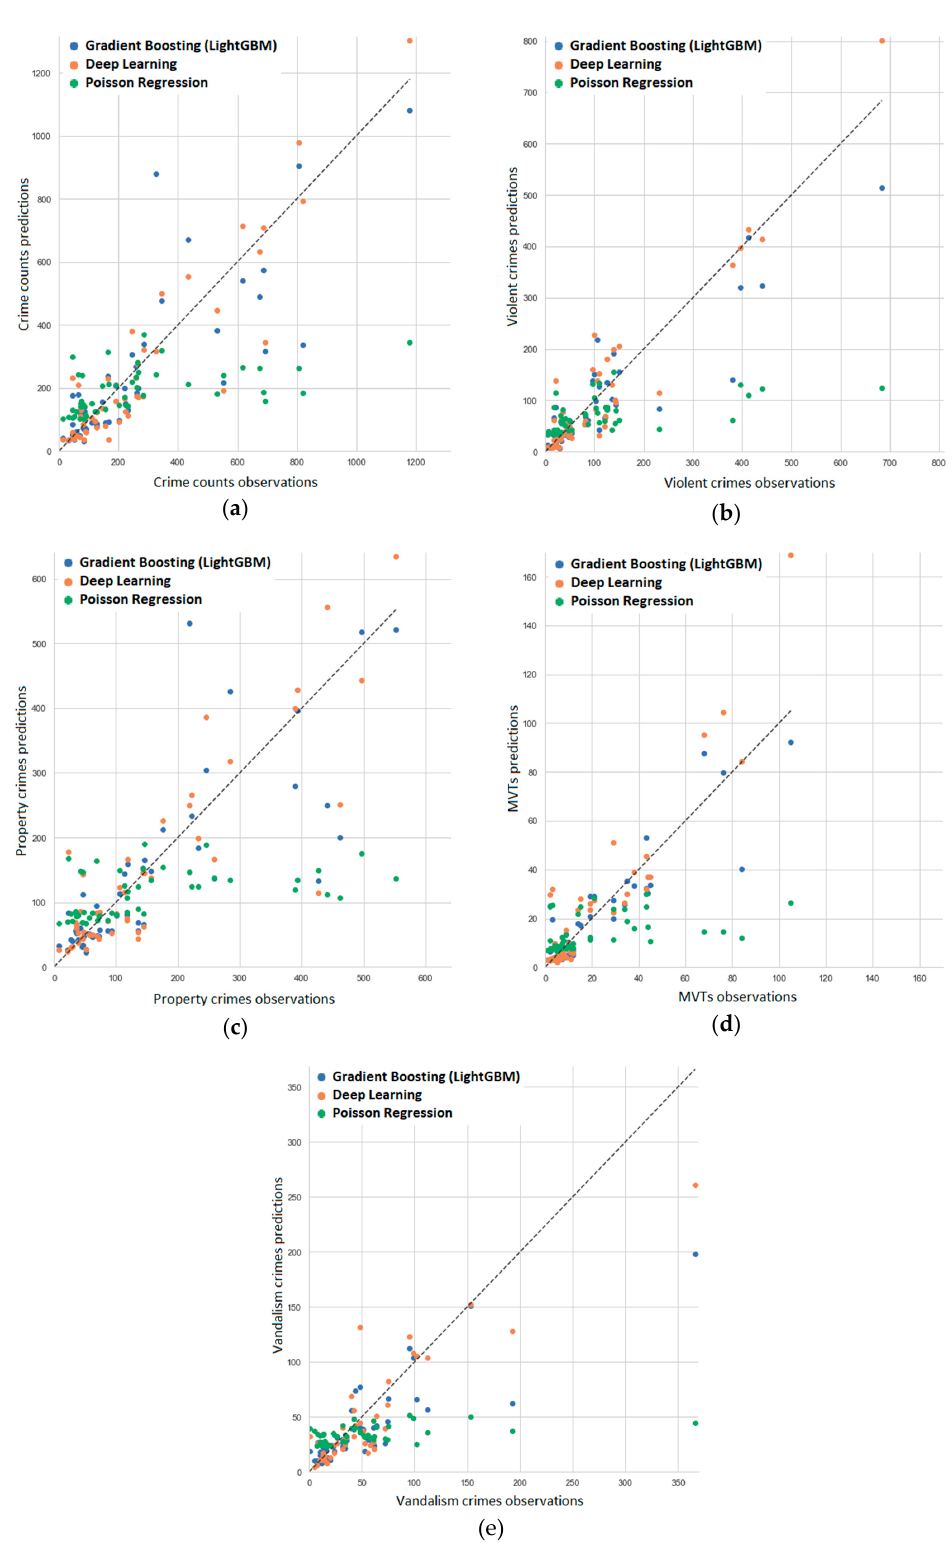
Figure 3. Comparison of the predicted occurrences of crimes against the ground truth using three different models. ( a ) Total crime count: predictions vs. real observations; ( b ) violent crimes: predictions vs. real observations; ( c ) property crimes: predictions vs. real observations; ( d ) MVT: predictions vs. real observations; ( e ) vandalism: predictions vs. real observations.